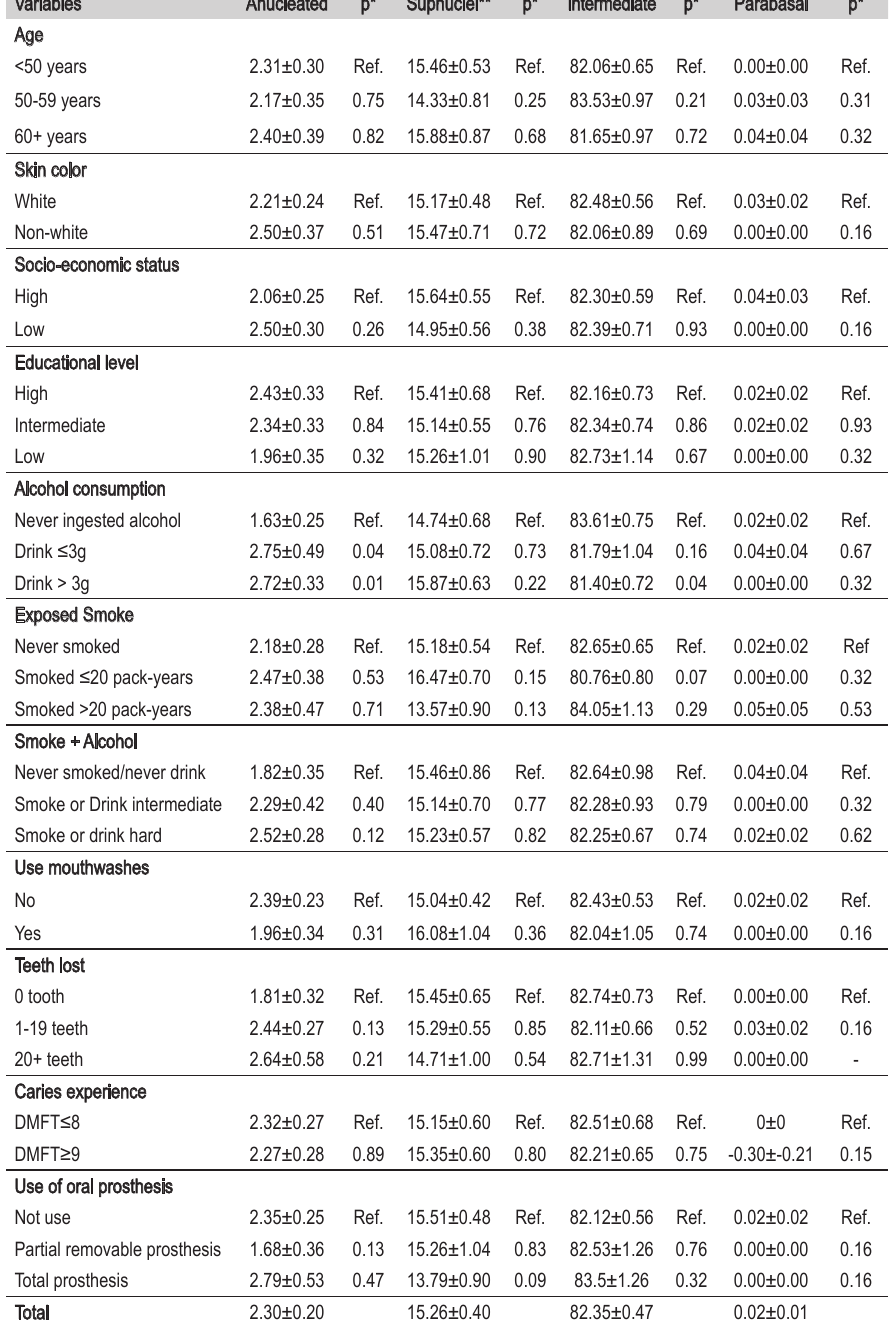
Table 3 - Mean distribution (standard error) the percentage of the type of cells on the floor of the mouth according to independent